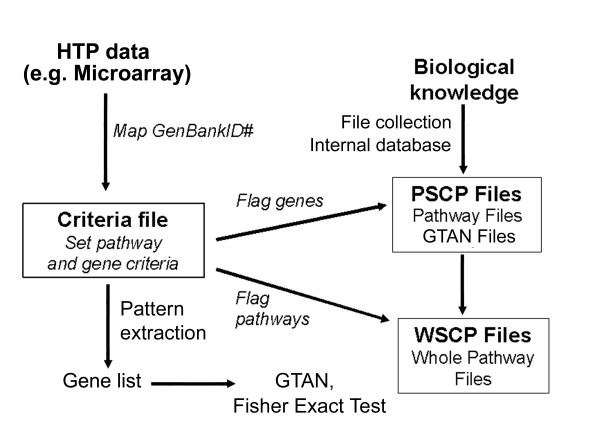
Overview of WholePathwayScope (WPS): schematic work flow for WPS basic data and file processing. WPS imports the data from the microarray file to the criteria (CRI) file, from which gene lists can be obtained by pattern extraction and then subjected to statistical evaluation by Fisher's exact test or to generate a GTAN. The GenBank IDs of genes in microarray datasets and pathway files (PSCP and WSCP files) are mapped to BaseGenBankIDs. The user then sets the criteria by which the gene tags and pathway tags in the PSCP and WSCP files are to be colored. PathwayScope Files (PSCP) including the GTAN (gene-term association network) files and WholeScope Files (WSCP) are either provided or created by the user. WPS integrates the data from the CRI files with the PSCP and WSCP files so that genes and pathways are flagged according to the specifications of the user.